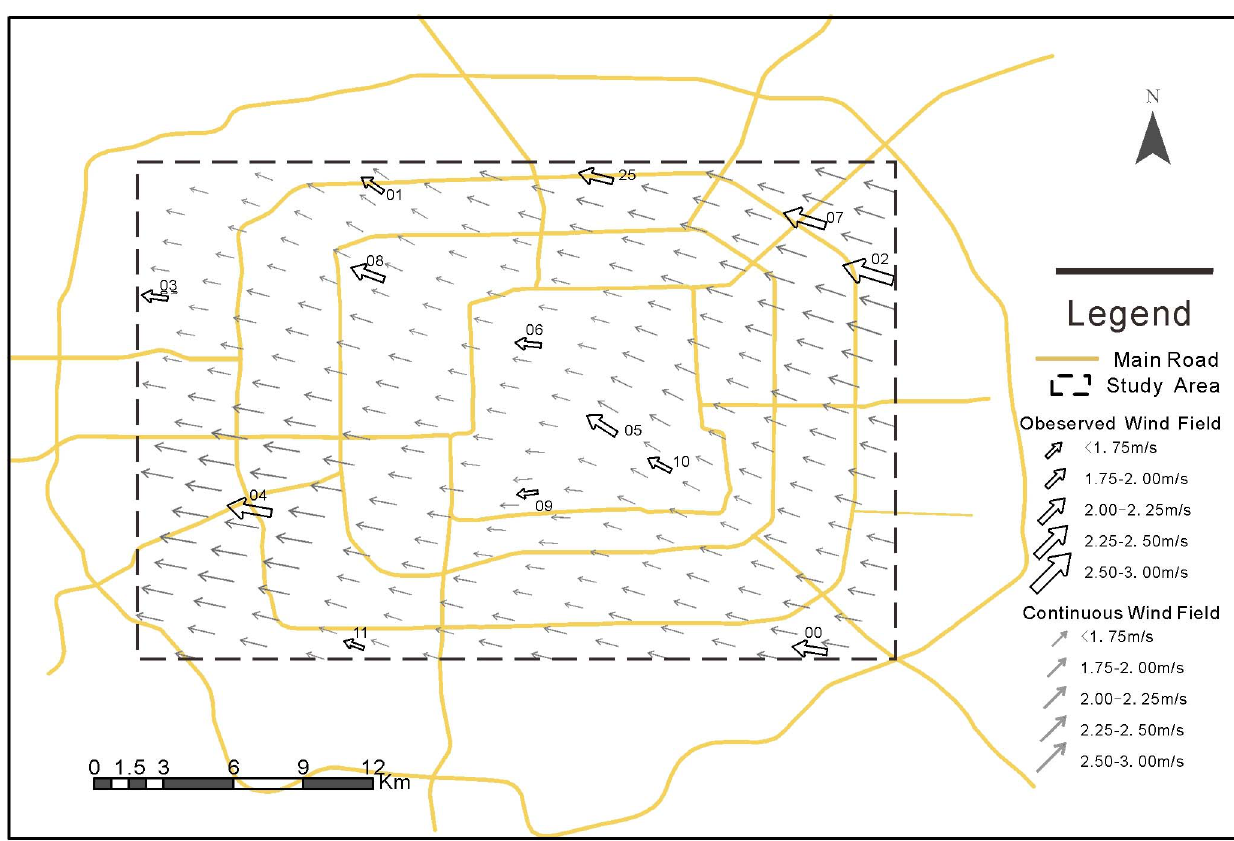
Figure 2. Observed wind-field and continuous wind-field generated from the monitoring data of May 28 th .